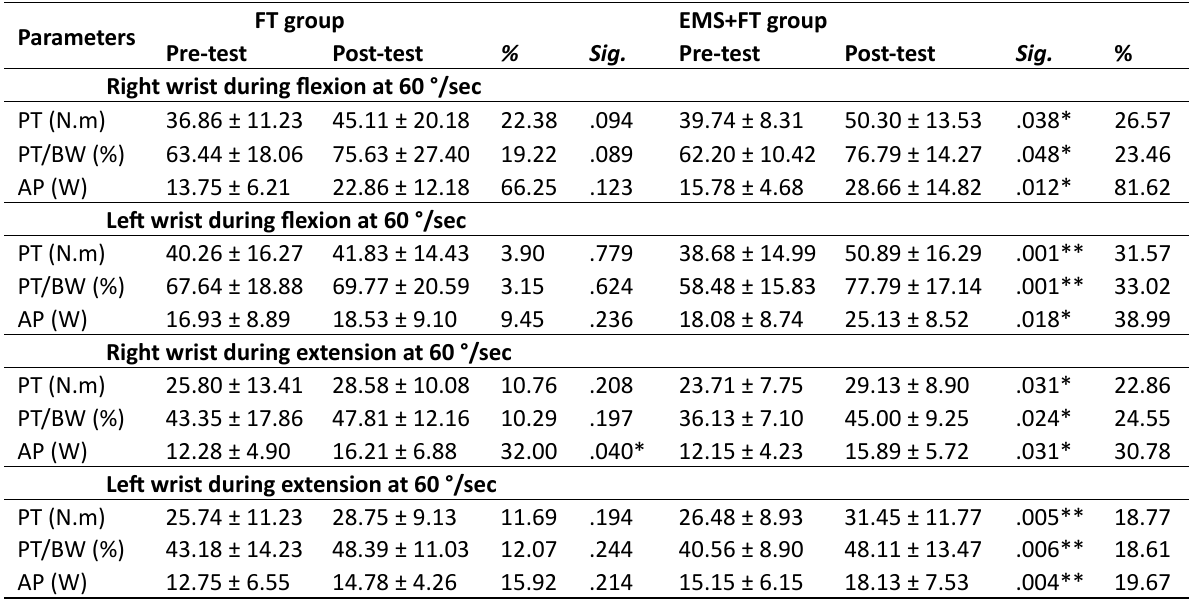
Table 2. Isokinetic strength values and their mean differences obtained from pre and post-tests at 60 °/s for both right and left wrists during flexion and